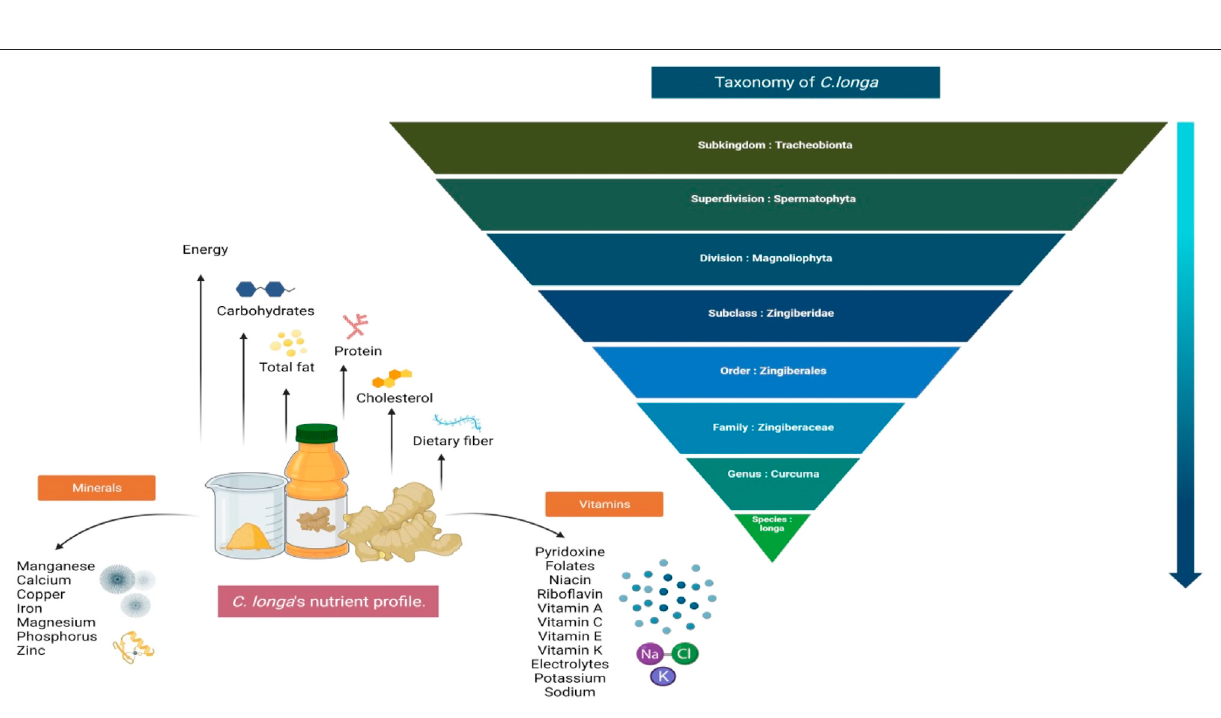
FIGURE 2 | The taxonomic classi fi cation and nutritional pro fi le of C.